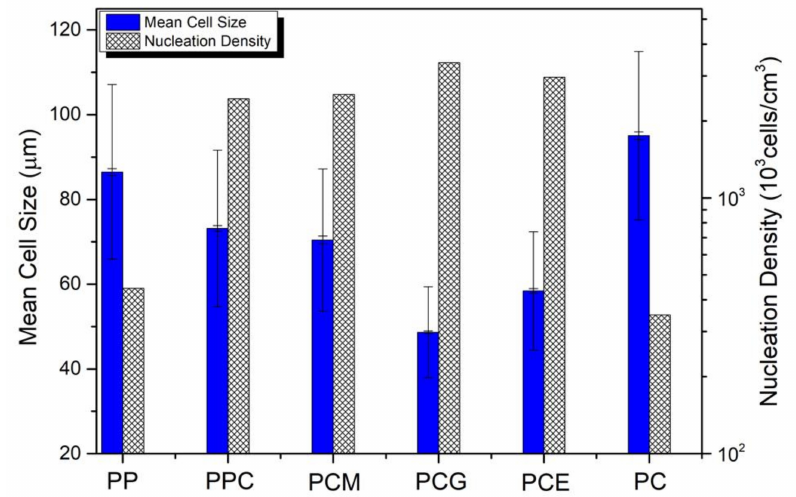
Figure 6. Statistic results of cell size and cell density from the SEM images of Figure